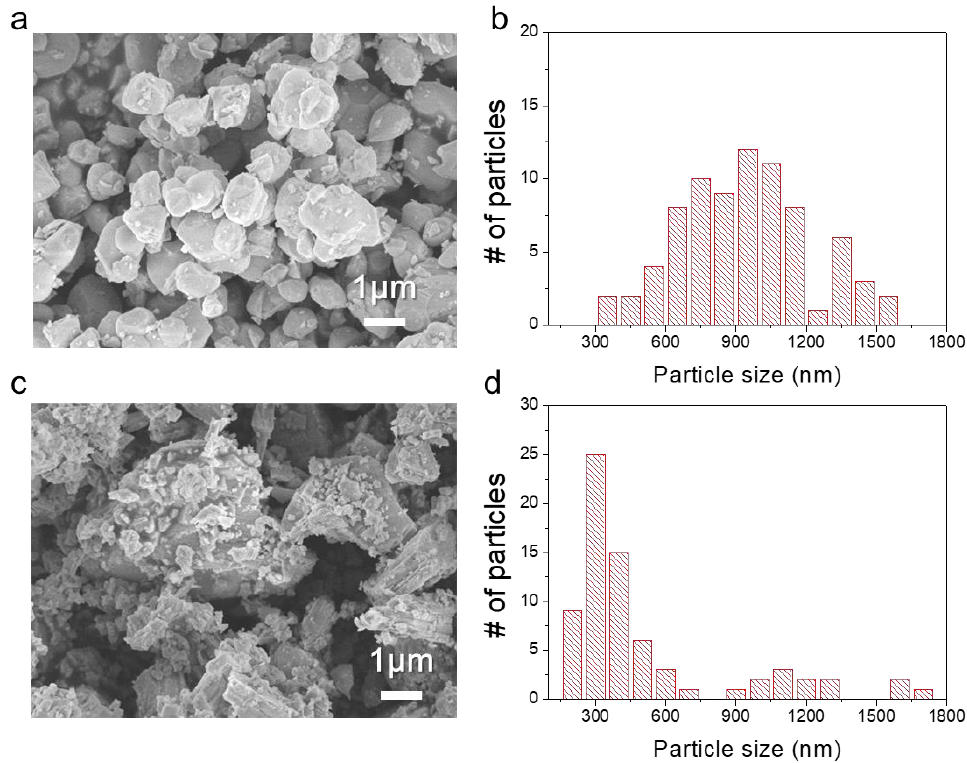
Figure 2. Field emission scanning electron microscopy images and corresponding particle size distributions of SrBi 2 Nb 2 − x V x O 9 powders. ( a , b ) x = 0 (SBNV0) and ( c , d ) x = 0.06 (SBNV06).